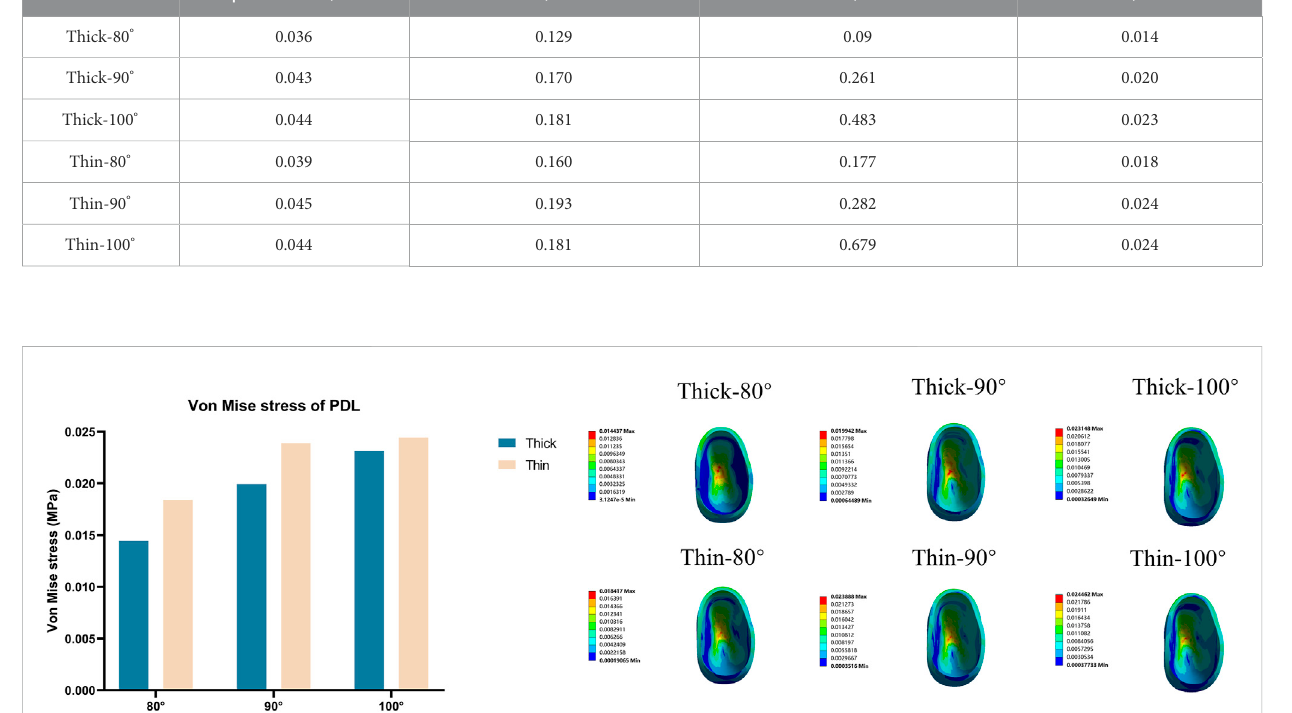
TABLE 3 Tooth displacement, von Mise stress of the tooth root, the alveolar bone and the PDL of the central incisor in various models (Thick-80 ° ; Thick-90 ° ; Thick- 100 ° ; Thin-80 ° ; Thin-90 ° ; Thin-100 ° ). Various models